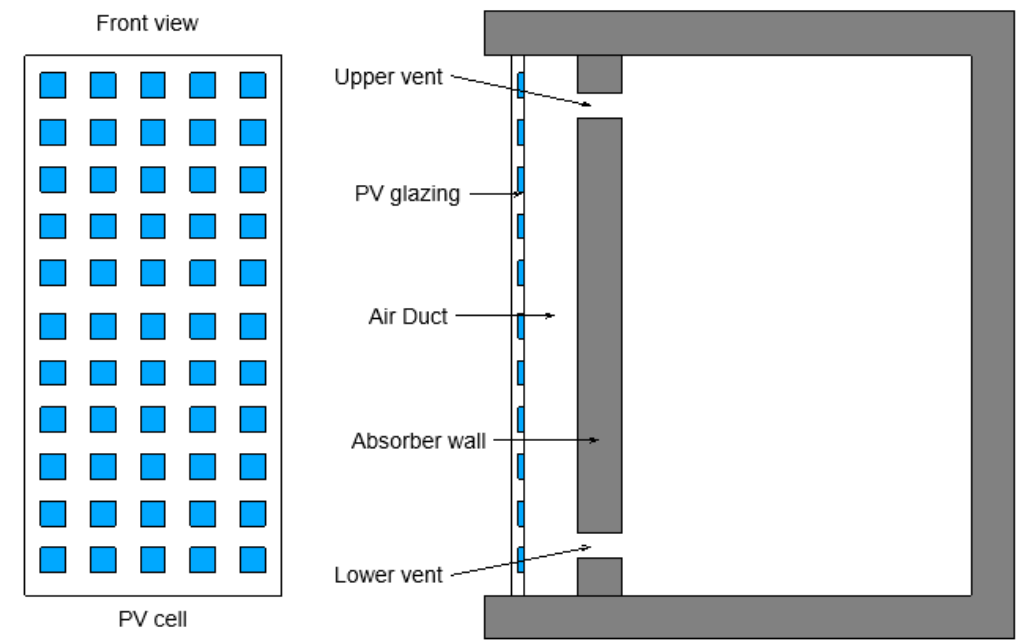
Figure 7. Schematic representation of the photocell Trombe wall (data from ref. [80,81]).